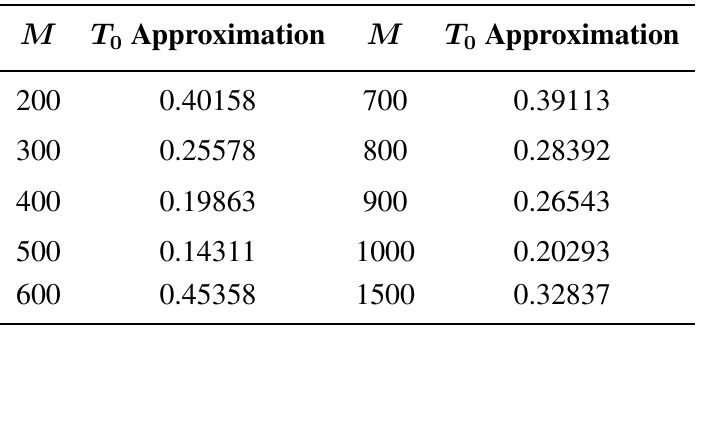
Table 3. Approximations of T in the four-pole example with perturbation 10 − 5 sin(10 πx ) 0 using extrapolations with original fitting regions for various M . The exact value T averaged value T ( aver ) 0